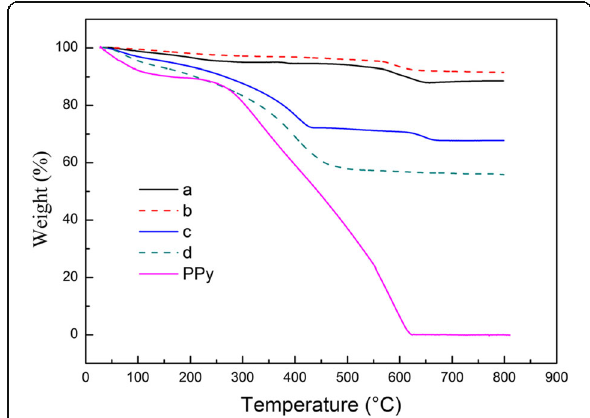
Fig. 4 TGA curves of PPy and MnO 2 samples. ( a ) urchin-like MnO 2 sample, ( b ) caddice-clew-like MnO 2 sample, ( c ) 30 μ L PPy-coated urchin-like MnO 2 sample, and ( d ) 50 μ L PPy-coated caddice-clew-like